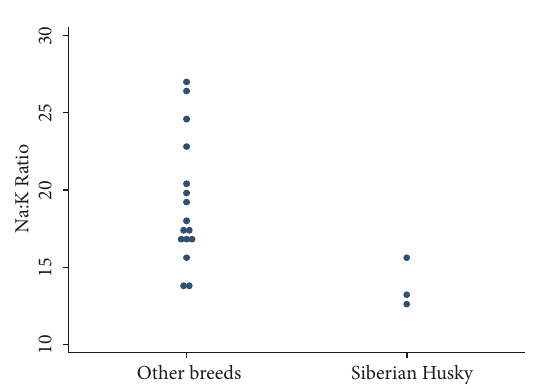
Figure 1: Dot plot comparing the Na:K Ratio for Siberian Huskies (n=3) to other breeds of dogs with Trichuriasis-associated pseu- dohypoadrenocorticism (n=16) reported in the literature [3, 5–8]. Analysed using Stata v14 (StataCorp LP, College Station,